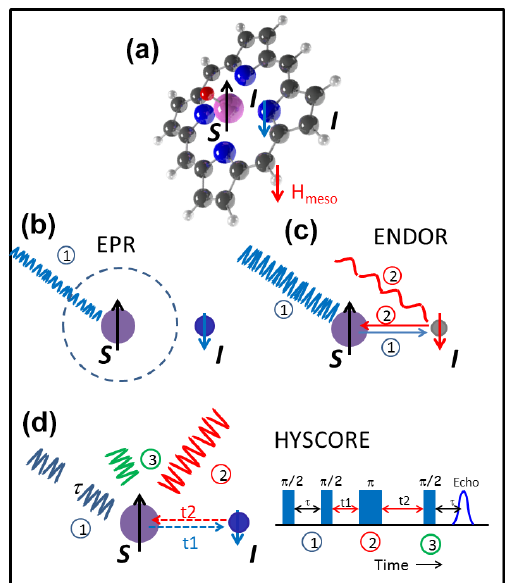
Figure 3. Principle of cw-ENDOR and HYSCORE spectroscopy. (a) Schematic structure of a porphyrin vanadyl complex, showing the electron spin S on vanadium and two nuclear spins I on nitrogen and on the bridging hydrogen H meso . (b) EPR with a non-saturating microwave field, the dashed circle representing the limited